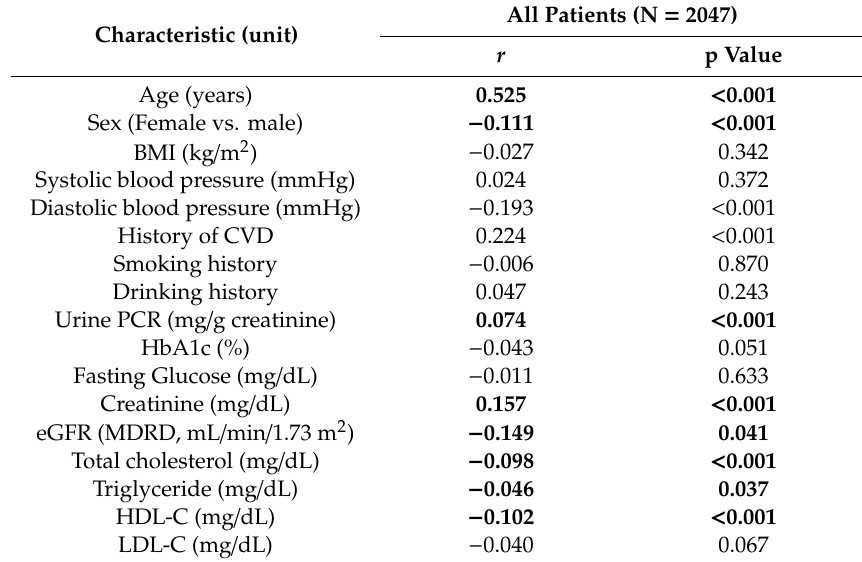
Table 2. Correlations between mean CIMT and other